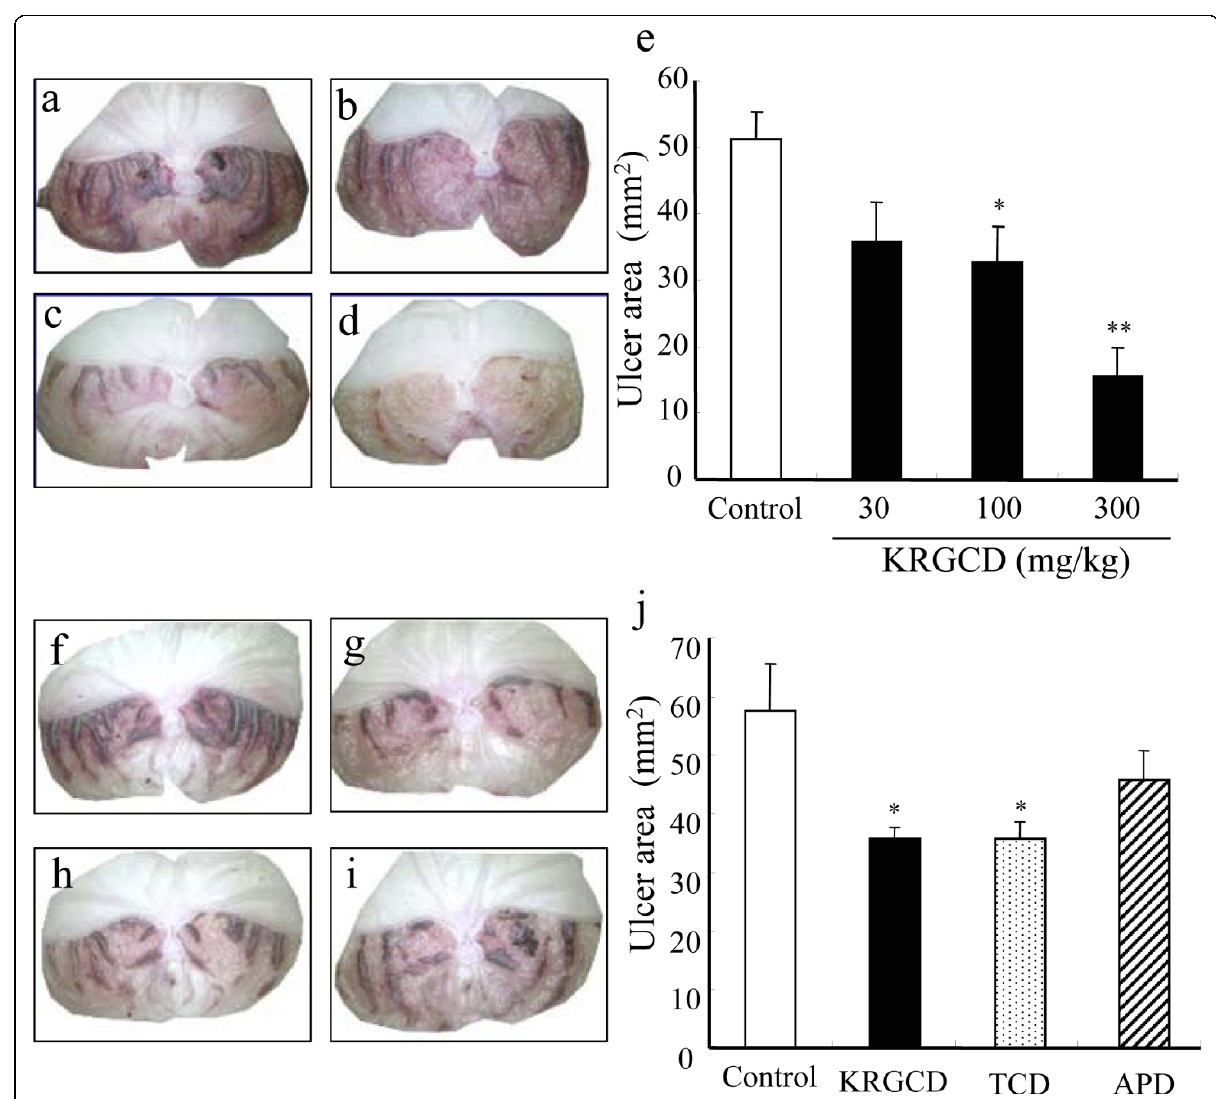
Figure 1 Protective effect of KRGCD on gastric mucosal lesions induced by HCl/ethanol in mice . Stomachs from mice with vehicle (a) and pretreated with KRGCD at doses of 30 mg/kg (b), 100 mg/kg (c), and 300 mg/kg (d) at 1 hr before HCl/ethanol administration. Quantitative analysis of KRGCD on the ulcer area (mm 2 ) induced by HCl/ethanol (e). n = 13 for each group. Each value represents the mean ± SEM. * p < 0.05, ** p < 0.01 vs. control mice, Dunnett ’ s multiple-range test. Stomachs from mice with vehicle (f) and pretreated with KRGCD (100 mg/kg) (g), TCD (76 mg/kg) (h), and APD (96 mg/kg) (i) at 1 hr before HCl/ethanol administration. Quantitative analysis of KRGCD, TCD, or APD on ulcer area (mm 2 ) induced by HCl/ethanol (j). n = 8 for each group. Each value represents the mean ± SEM. * p < 0.05 vs. control mice, Student ’ s t